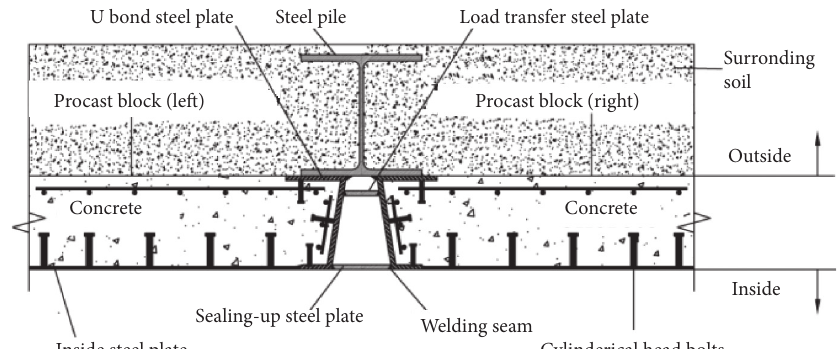
Figure 3: Vertical joints of composite wall.